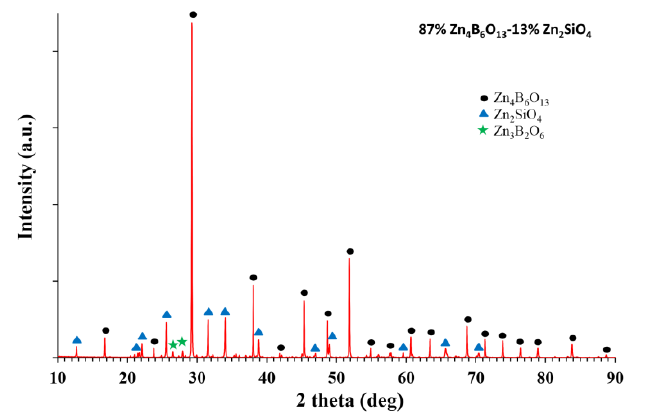
Figure 2. Diffraction pattern of 87% Zn 4 B 6 O 13 –13% Zn 2 SiO 4 ceramic sintered at 930 °C. Two dominant crystalline phases were detected—Zn 2 SiO 4 (hexagonal crystallographic system, R-3 group) and Zn 4 B 6 O 13 (cubic crystallographic system, I-43m group). For the samples containing 10, 13, 15, and 20% willemite, another zinc borate Zn 3 B 2 O 6 was found as an additional crystalline phase. The amount of this phase was 7% for 87% Zn 4 B 6 O 13 –13% Zn 2 SiO 4 ceramic and about 5% for the other materials from this group. For the ceramics with 40, 50, and 60% willemite, only two starting crystalline phases were